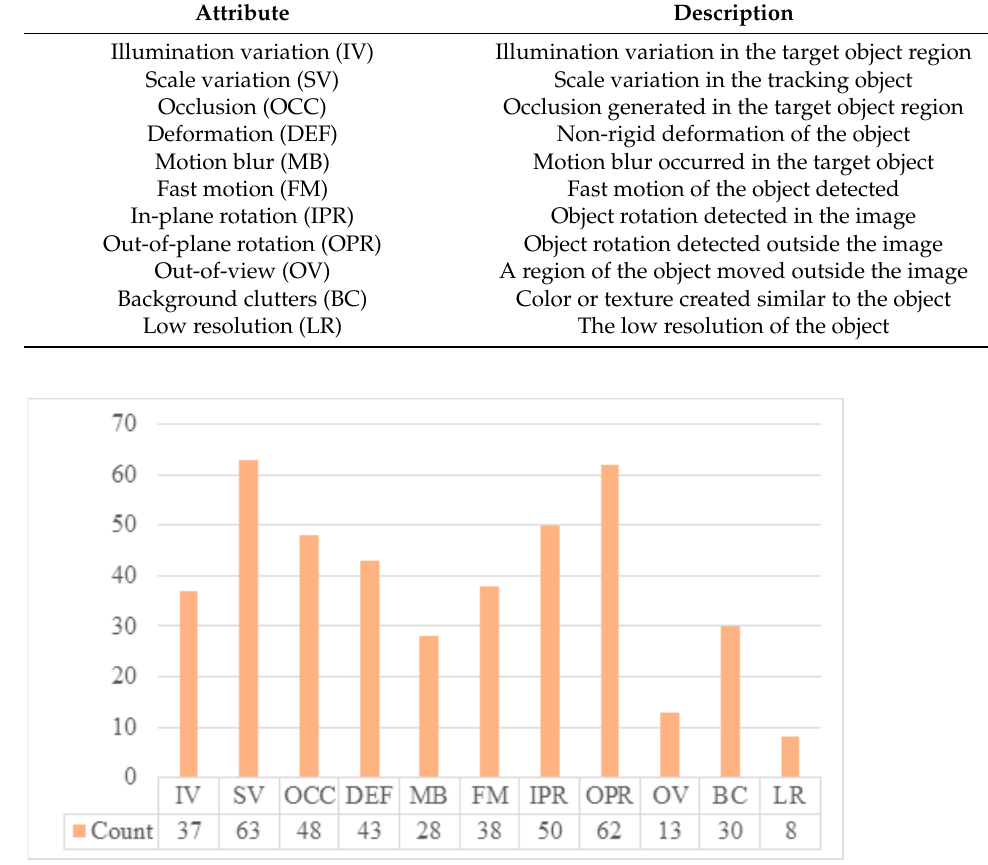
Figure 9. Sequence Distribution Graph about Attributes.